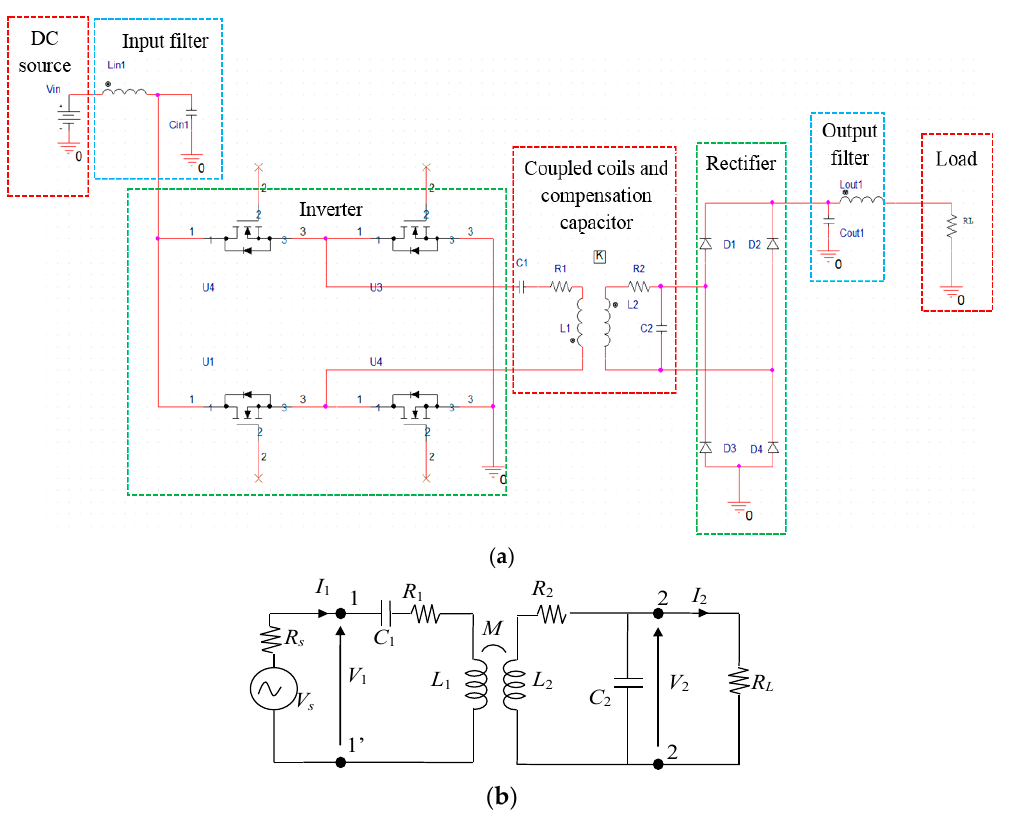
Figure 3. WPT charging system with series-parallel (SP) compensation: complete electrical circuit ( a ), and simplified equivalent circuit of two coupled coils ( b ).